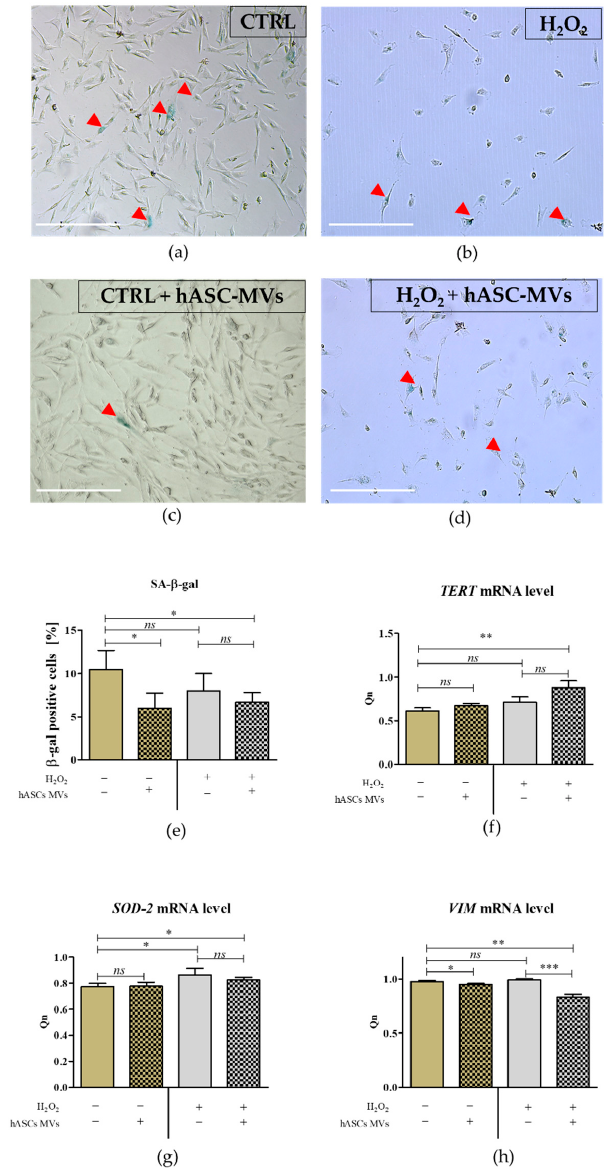
Figure 6. The analysis of the senolytic action of MVs both in control and oxidative stress induced cultures ( a – d ). The β -galactosidase positive cells are marked with red arrows. The number of cells was counted using ImageJ software and analyzed statistically ( e ). The expression of markers associated with cell senescence was measured using RT-qPCR. Following transcripts were measured: telomerase reverse transcriptase ( TERT; f ); mitochondrial superoxide dismutase 2 ( SOD-2 ; g ) and vimentin ( VIM ; h ). The transcripts levels were normalized (Qn) to the reference gene (here: Glyceraldehyde-3-Phosphate Dehydrogenase; GAPDH). The normalized values (Qn) were analyzed using statistical tests. The significant differences are marked with asterisks (* p < 0.05; ** p < 0.01 and *** p < 0.001) and differences between healthy cultures and cultures with induced oxidative stress are marked in red font. The results are expressed as mean ± S.D.